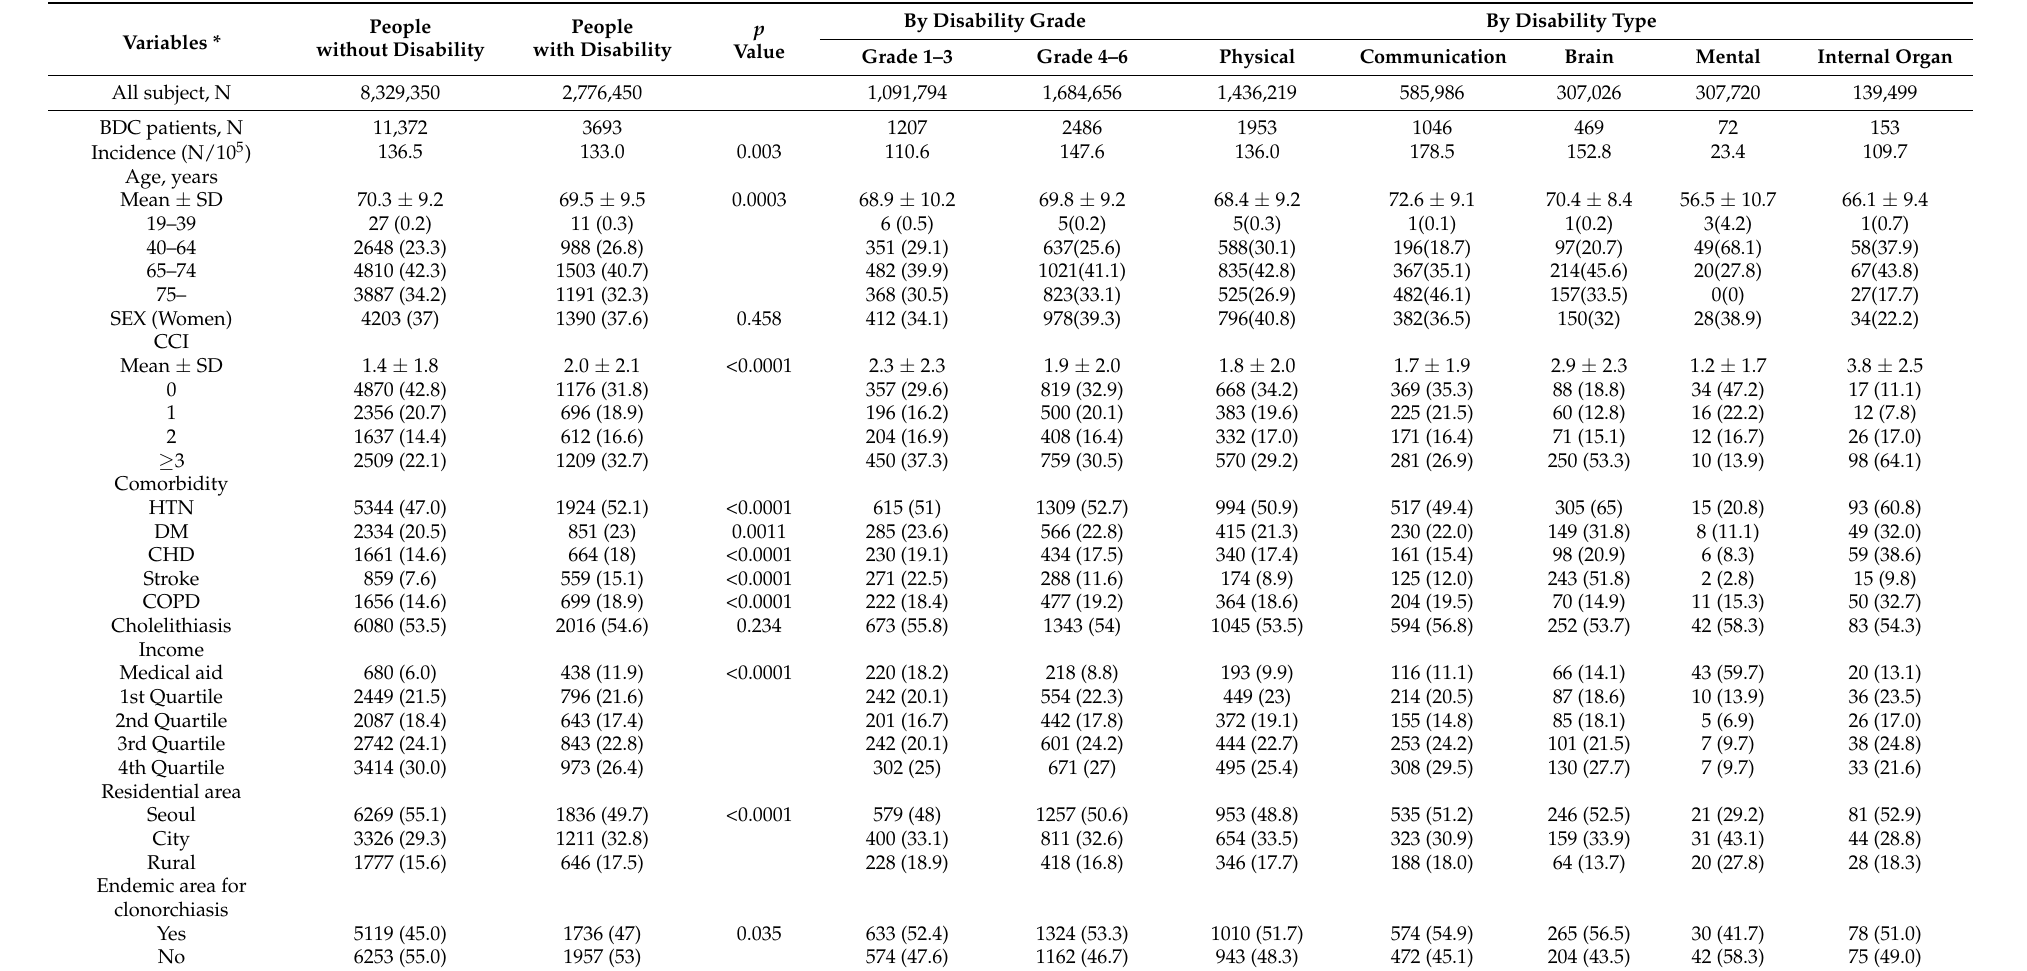
Table 1. General characteristics of the patients with bile duct cancer